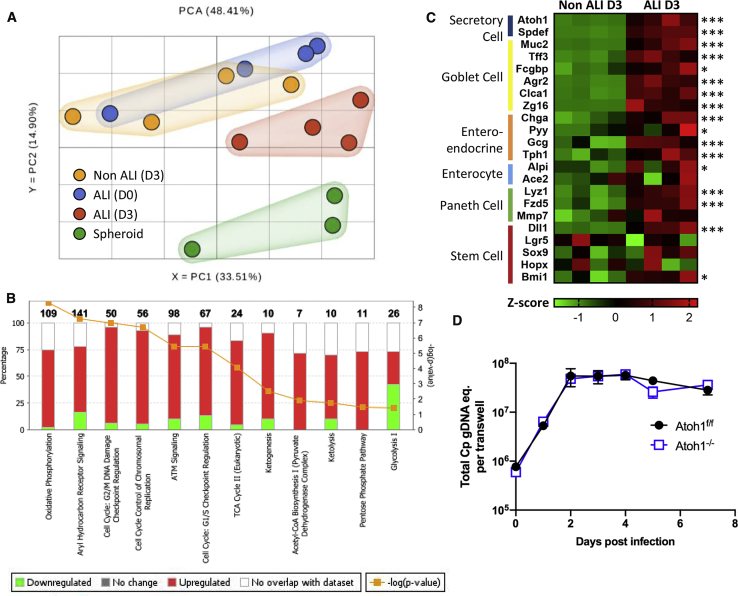
Pathway Analysis of Transcriptomes from Stem Cells and Differentiating ALI Cultures(A) Principal-component analysis (PCA) of normalized expression values for all genes in stem cell spheroids (green), transwells on day 0 (ALI D0, blue) or day 3, either after medium removal (ALI D3, red) or with continuous medium (non-ALI D3, yellow). Two independent experiments with two replicates per experiment except for the spheroid group, in which one technical replicate was removed from downstream analyses due to poor quality reads (see STAR Methods).(B) Bar chart of the percentage of genes upregulated (red) or downregulated (green) in day 3 ALI versus non-ALI samples for the most significant pathways (p < 0.05) under the “generation of precursor metabolites and energy” and “cell cycle regulation” pathways, respectively. Numbers in bold indicate the total number of genes per pathway. Performed in ingenuity pathway analysis (IPA) using expression values for all genes as input. See also Figure S4.(C) Heatmap of expression differences between day 3 non-ALI and ALI samples. The Z-score indicates the number of standard deviations that the expression value of each sample is above (red) or below (green) the mean expression value for all samples in the analysis. FDR-corrected p values for differential expression were determined in Partek using gene specific analysis (GSA): ∗q < 0.05, ∗∗∗q < 0.001.(D) Comparison of C. parvum growth in Atoh1−/− knockout (blue) or matched floxed Atoh1f/f control (black) ALI cultures infected with 2 × 105 unfiltered oocysts. C. parvum genomic equivalents (eq.) measured by qPCR for the C. parvum GAPDH gene. Means ± S.D. from two transwells per time point from a representative experiment. See also Figure S5.